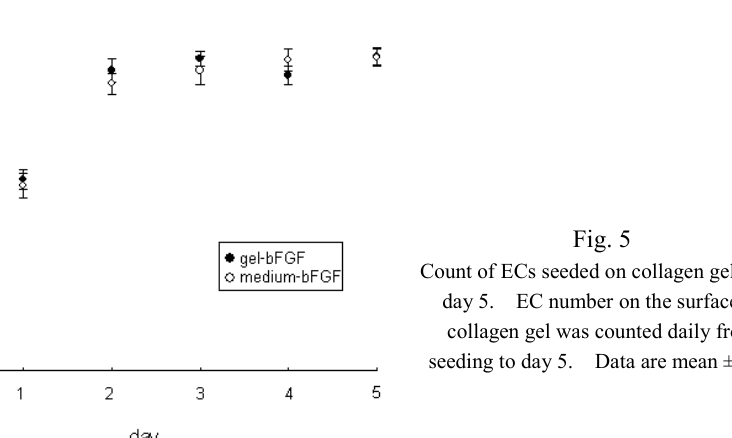
Fig. 5 Count of ECs seeded on collagen gel up to day 5. EC number on the surface of collagen gel was counted daily from seeding to day 5. Data are mean ±